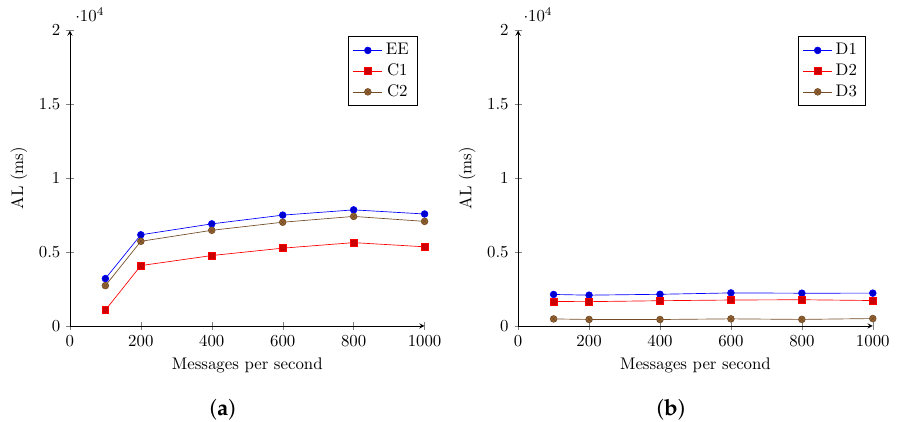
Figure 8. AL registered for the second stage evaluation. LoRaWAN for 100 simulated devices, and three instances of IoTAgent-LoRaWAN. ( a ) Registered latencies for monitored components and end to end. ( b ) Differences in recorded latencies between